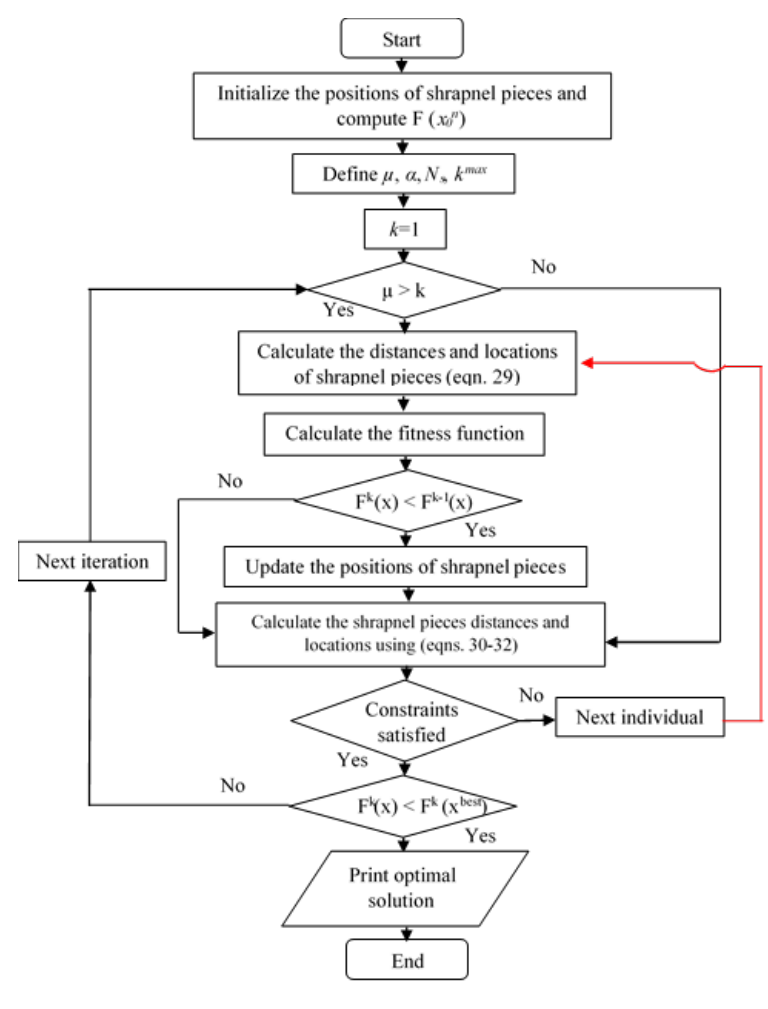
Figure 7. Flowchart of MBA.